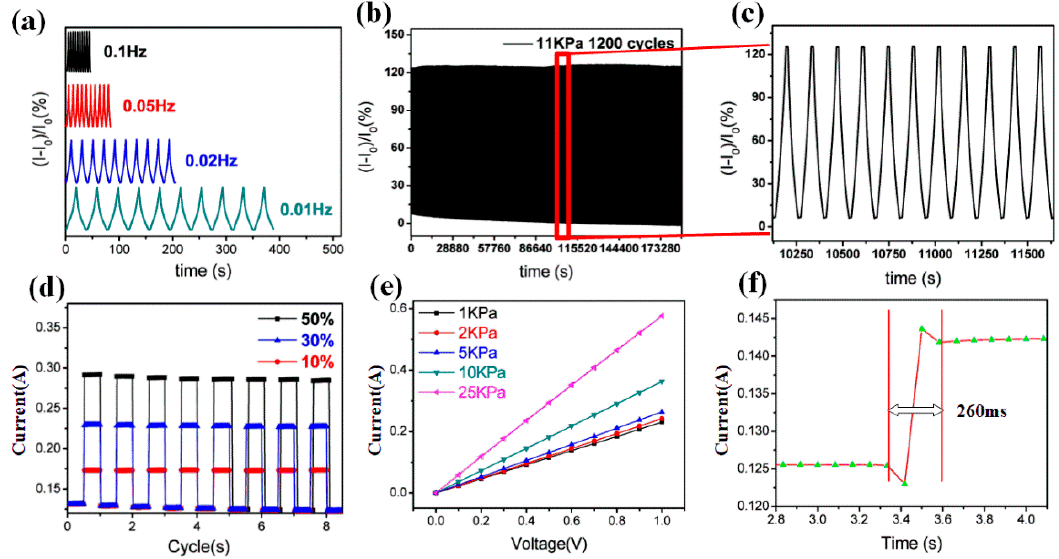
Figure 5. ( a ) Current response at different frequencies under 11 kPa. ( b ) Stress-current